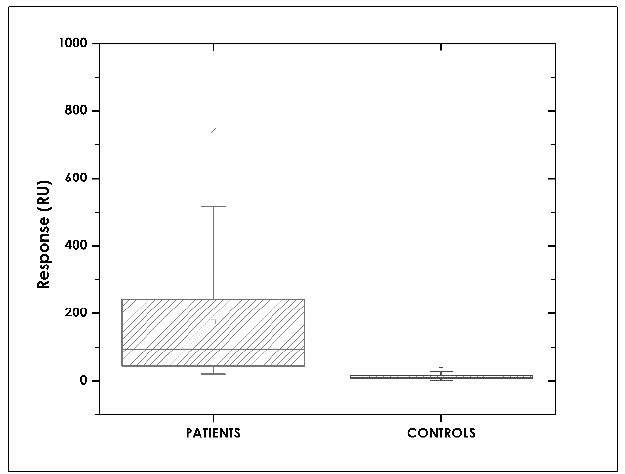
Figure 6. Resonance units (RU) obtained for samples from patients and healthy volunteers; the results were significantly different (p < 0.005).